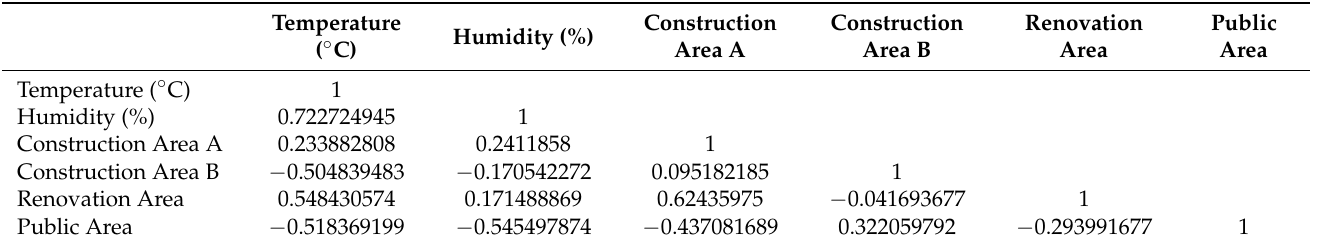
Table 7. Correlation coefficient (r) between meteorological parameters and PM 2.5 concentrations in different areas.